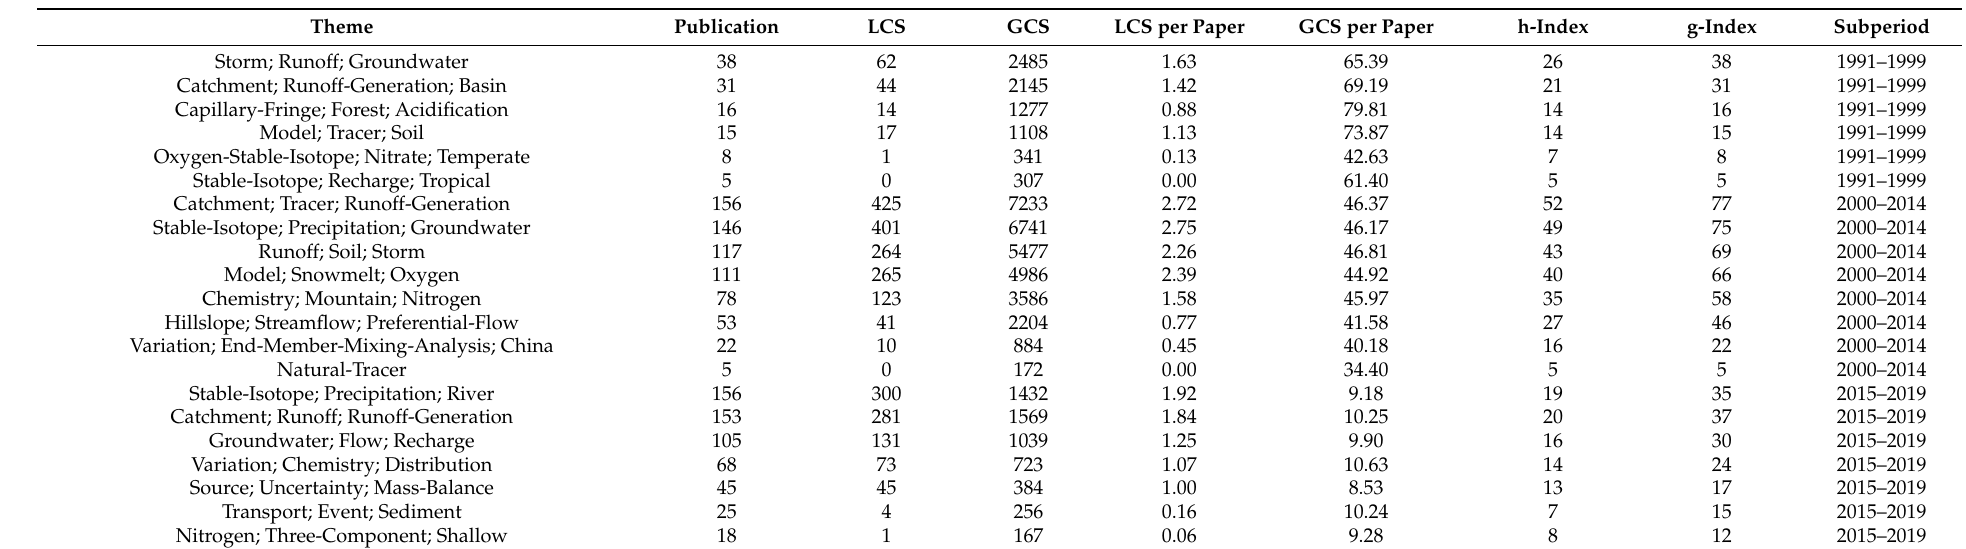
Table 6. Performance measures for the themes of each